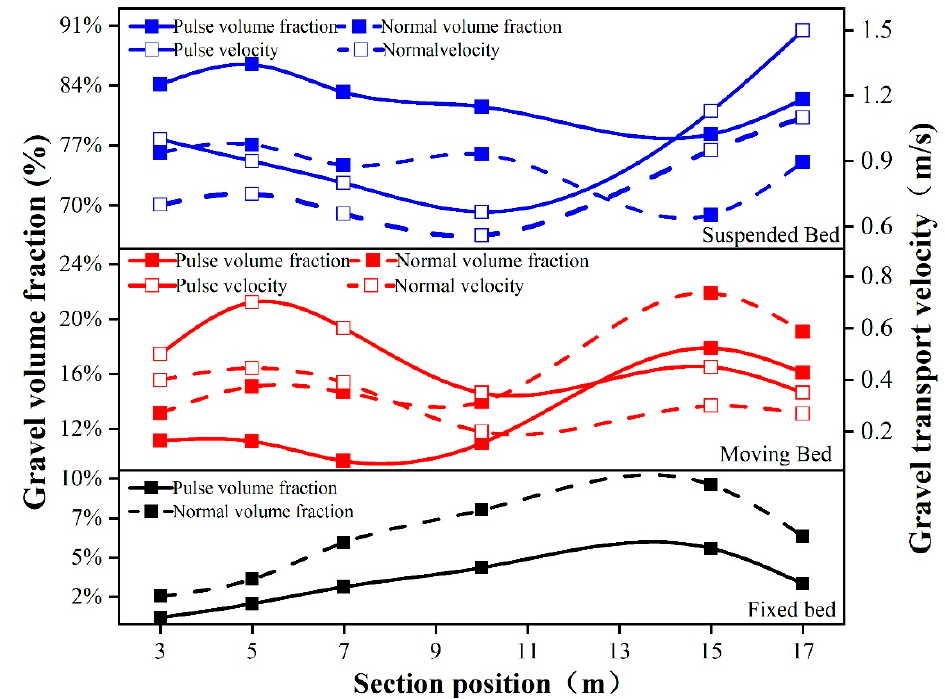
Figure 7. Graph of volume fraction and migration velocity for pulsed gravel packs and convention’s in horizontal wells .